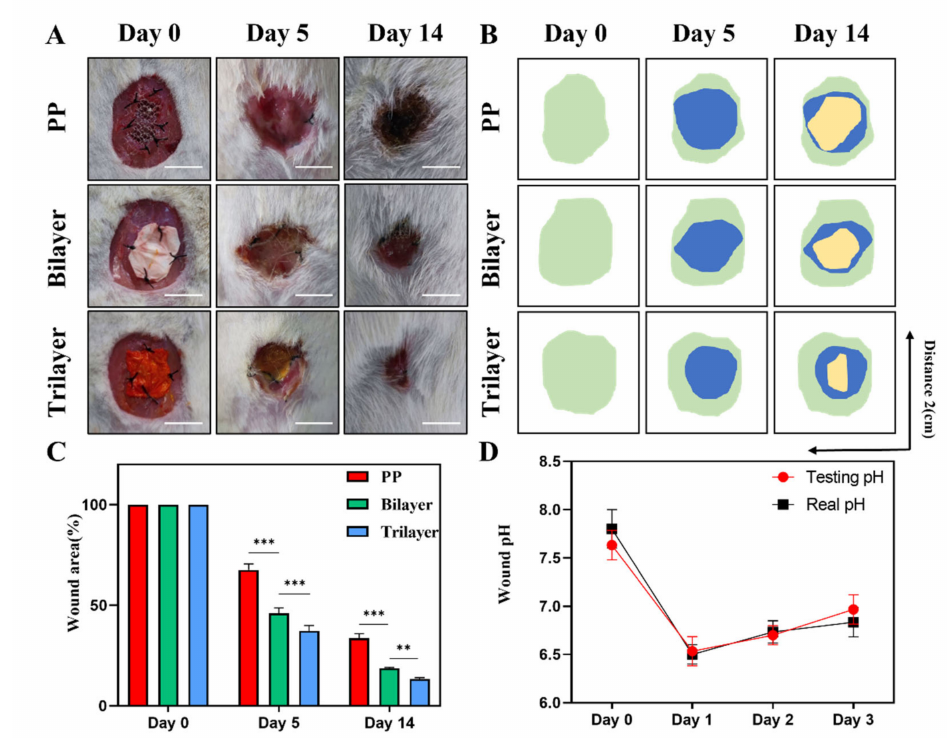
Figure 5. ( A ) Representative photograph of wounds on days 0, 5, and 14. ( B ) The typic abdominal wall healing photograph simulated by image software (Green: 0day, Bule: 5day, Yellow: 14day). ( C ) Abdominal wall healing rate of days 0, 5, and 14 ( n = 3). ( D ) The wound pH value of testing and real on days 0, 1, 2, and 3. Scale bars are 1 cm in ( A ) ( n = 3). (** p < 0.01, *** p < 0.001, ns = not significance, mean ±